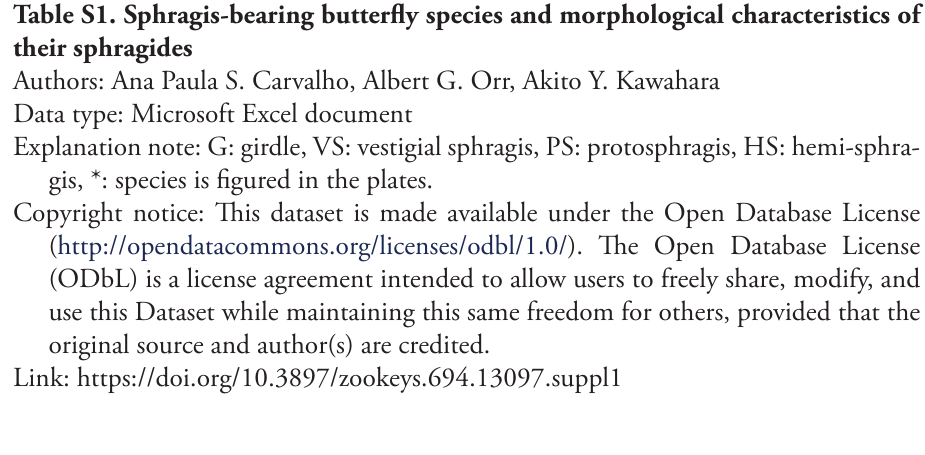
Table S1. Sphragis-bearing butterfly species and morphological characteristics of their